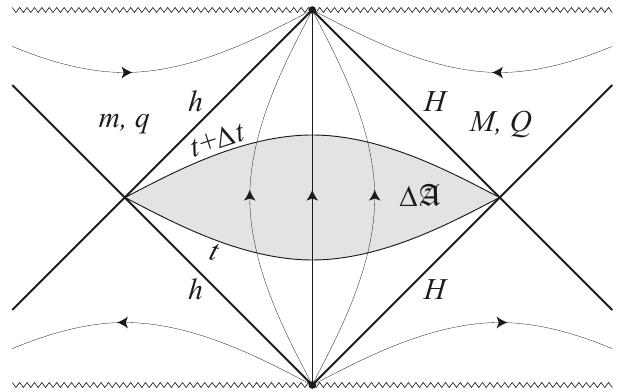
Figure 2 . A schematic conformal diagram of the axis between black holes. The static domain between both holes is bounded by horizons h and H . The orbits of the Killing vector @ t are indicated by lines with arrows. The worldsheet of the strut between two time lines t and t + (cid:1) t is in grey. It is spanned from the bifurcation neck of one horizon up to the bifurcation neck of the other horizon and it has area (cid:1) A . The zig-zag lines represent singularities inside black (and white)